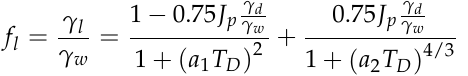
(cid:0) (cid:1) (cid:0) (cid:1) 0.01 + J p and 0.01/ 0.1 + J p , respectively; T D is